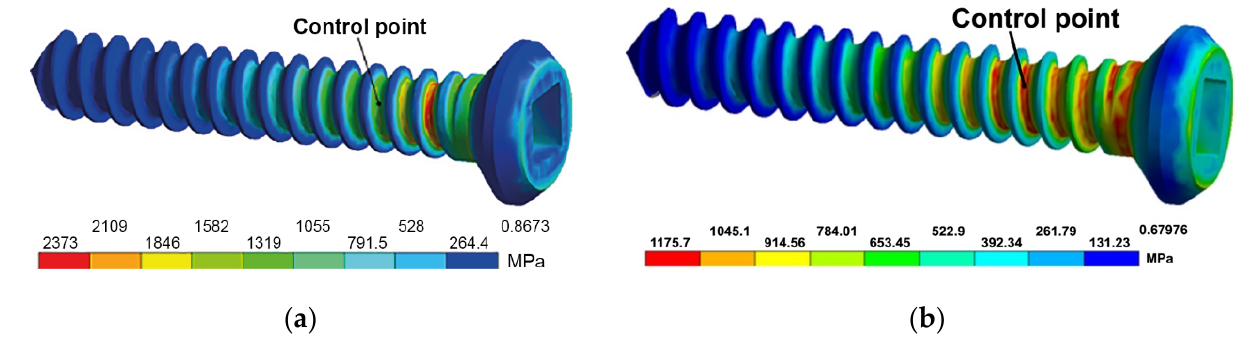
Figure 8. Equivalent stress in a UFG Ti screw for its elastic ( a ) and elasto ‐ plastic ( b ) models. The results of the torsional mechanical tests of the screws show (Figure 9a,b) that the torque leading to the fracture of UFG Ti screws is 1.2 times higher than the torque of the CG Ti screws. That being said, the rotation angles of the screws from CG and UFG Ti are